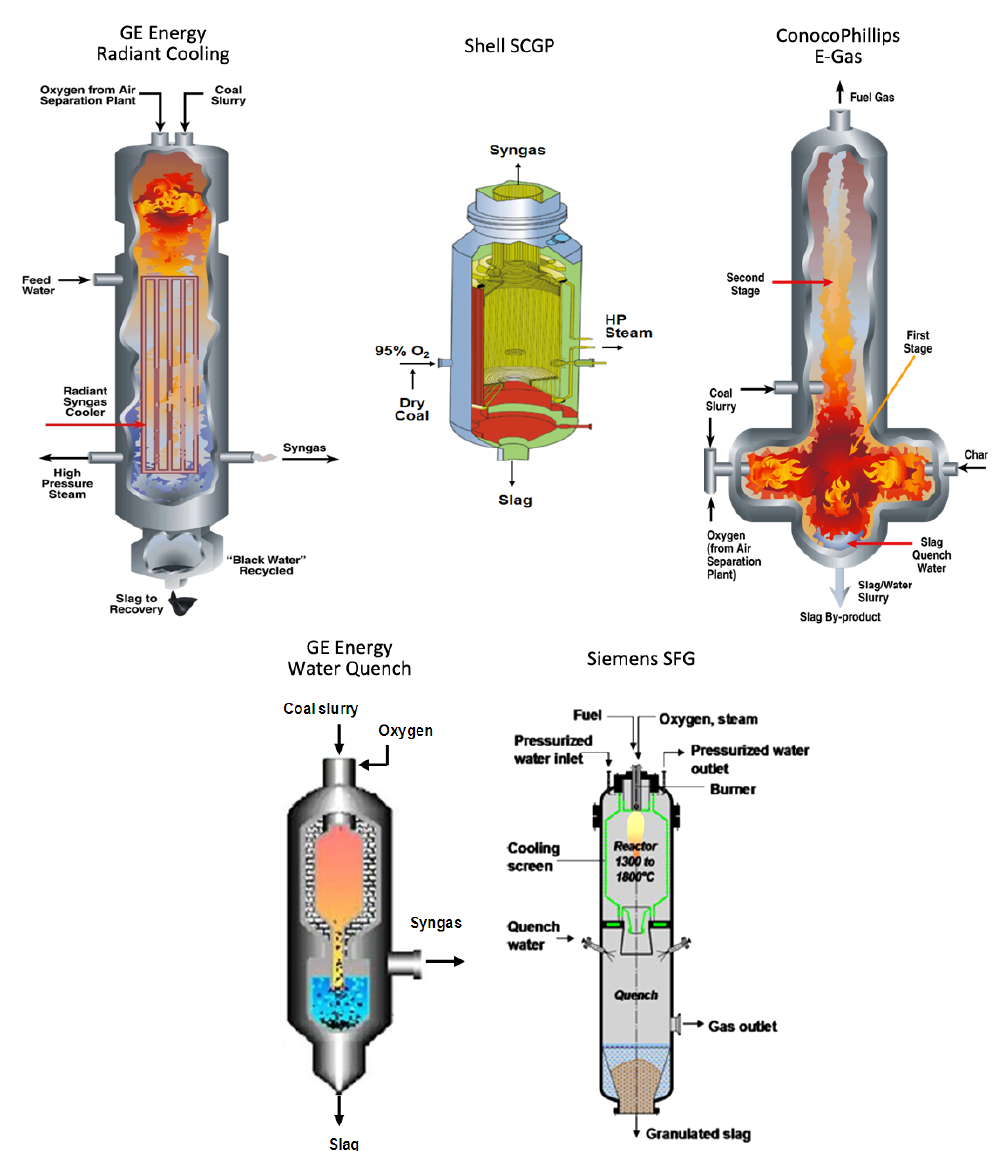
Figure 2. Characteristics of the major commercial entrained-flow gasifiers